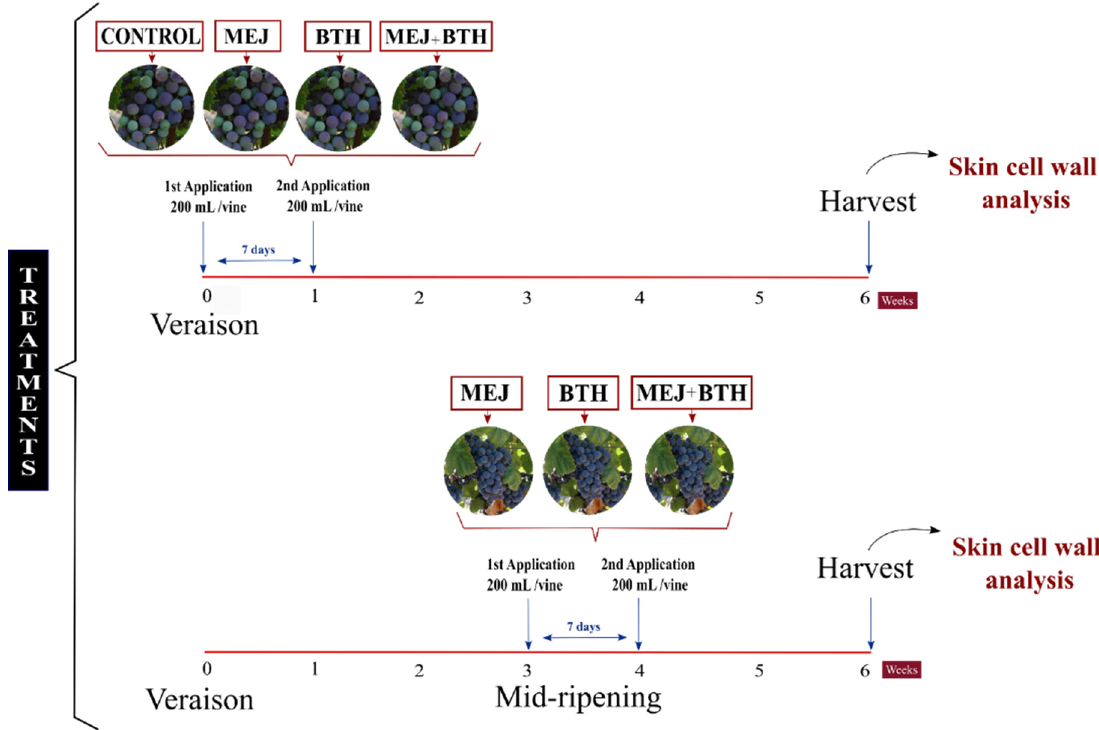
Figure 1. Application of treatments at two stages of ripening of Monastrell grapes.